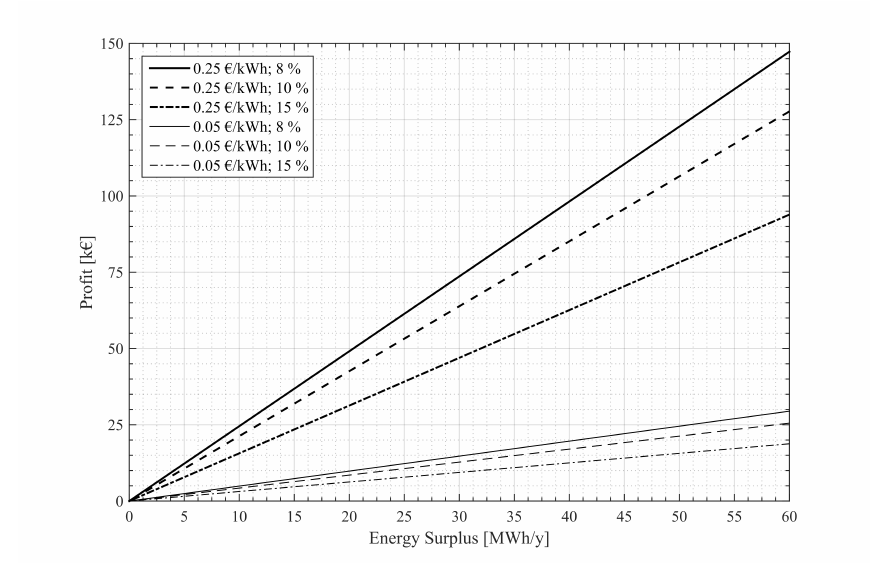
Figure 8. Budget for a compensation sytem as function of the energy surplus, the cost of electricity and the discount